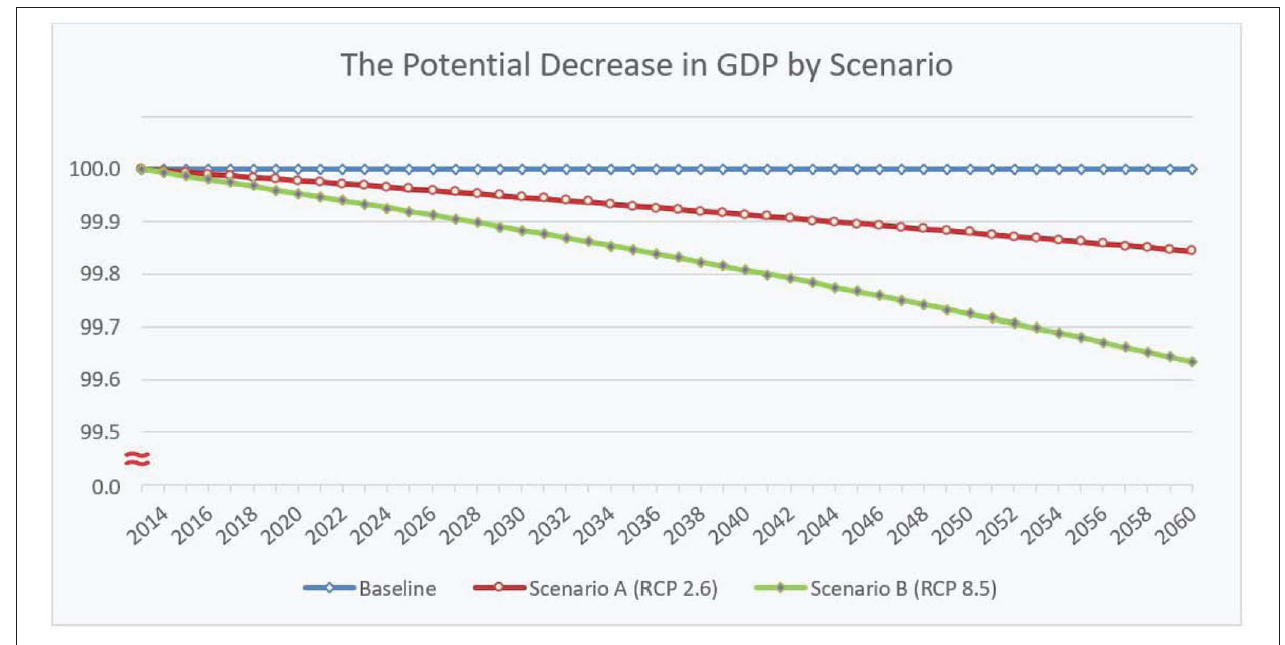
FIGURE 2 | Projection of decrease in GDP by scenario.